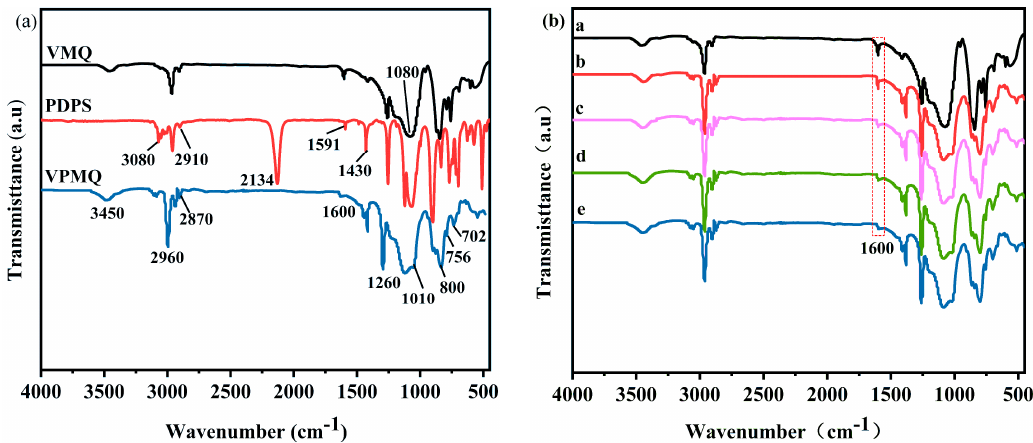
Figure 2. ( a ) Infrared spectra of VMQ, PDPS and VPMQ; ( b ) infrared spectra of VMQ and VPMQ series.